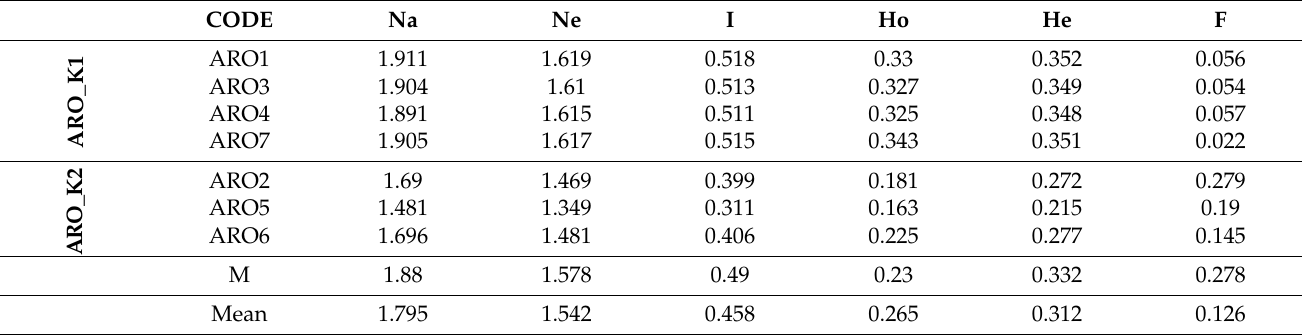
Table 2. Statistics on the onion populations genotyped in this